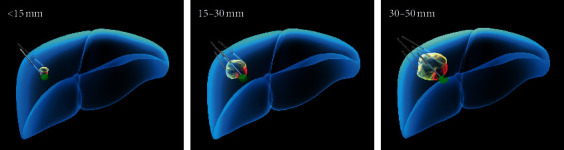
Depending on the biopsy and tumor size, multiple-site ablation would be performed to destroy tumors.